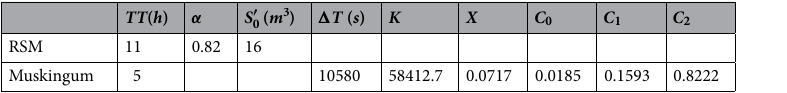
Table 5. Parameter of the simulation results for the Arrat’s reach.